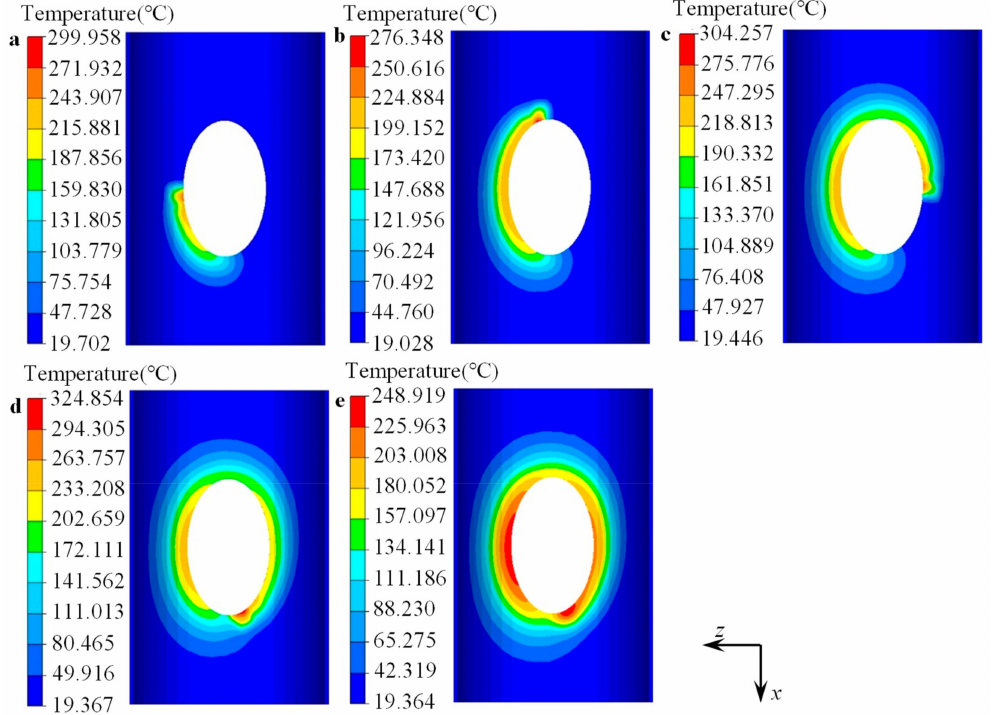
Figure 17. Distribution of temperature at chosen stages before flanging process: local heating ( a ) 25%, ( b ) 50%, ( c ) 75%, ( d ) 100%; ( e ) after